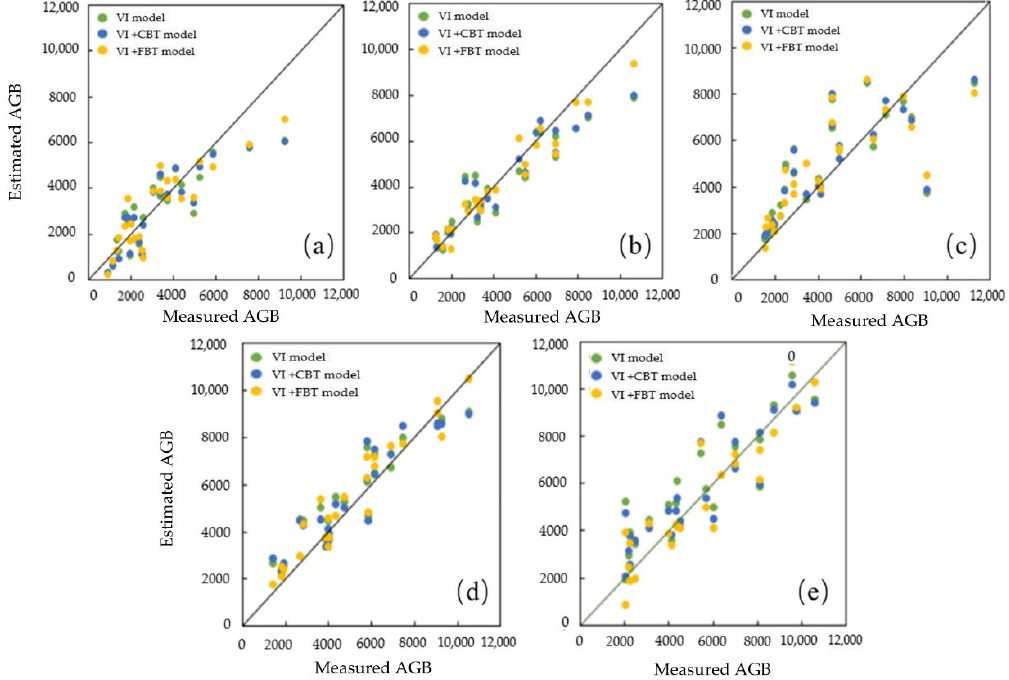
Figure 10. Scatter plot of AGB of three models under different nitrogen levels: ( a ) N0, ( b ) N1, ( c ) N2, ( d ) N3, ( e ) N4. Green: vegetation index model (VI model); blue: vegetation index combined with corresponding-band textures model (VI+CBT model); yellow: vegetation index combined with full-band textures model (VI+FBT